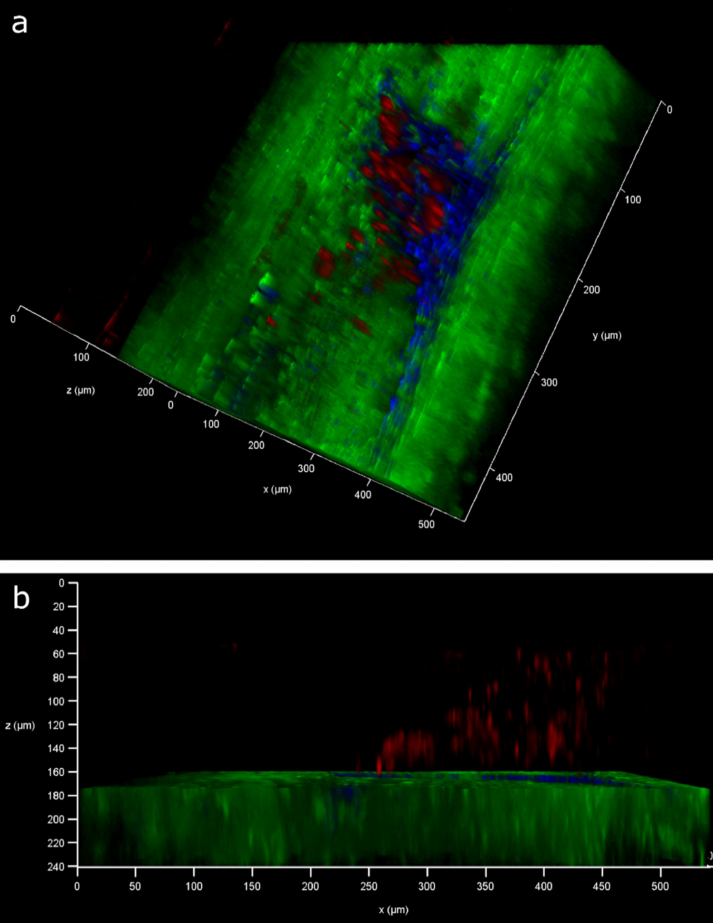
Figure 5. Three-dimensional visualisation of lesion site 21 days after injury. CD146 is labelled red, collagen is labelled green and nuclei labelled blue. Blue and green channels have been digitally removed in the centre of the tendon to allow for the visualisation of CD146-positive labelling within the lesion in sagittal ( a ) and transverse ( b )